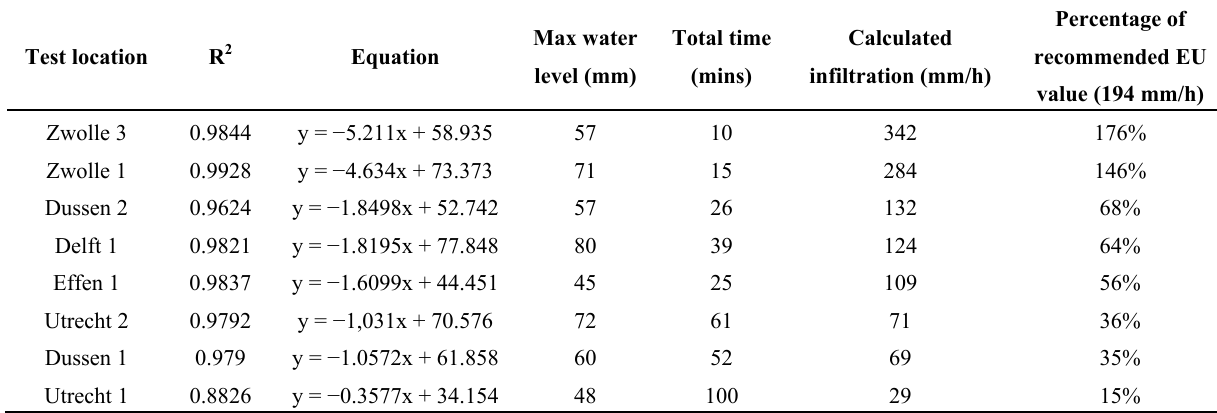
Table 2. Linear regression analysis results for the eight test